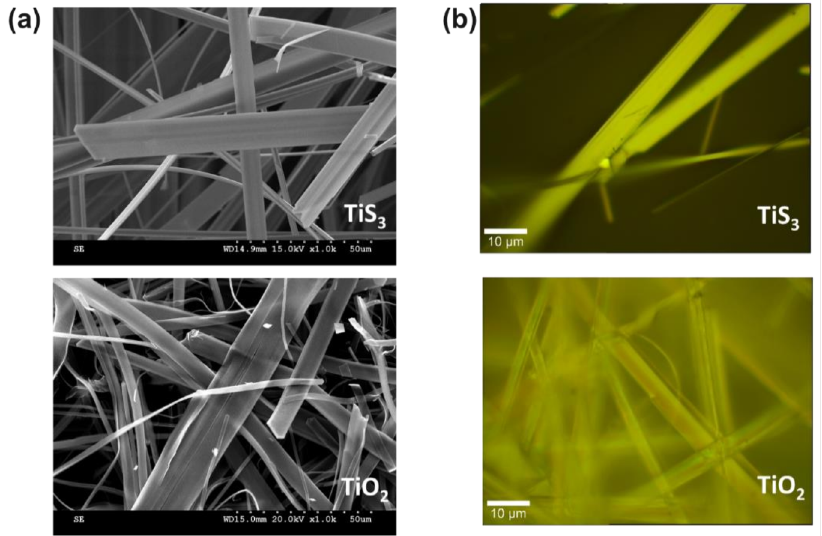
Figure 1. ( a ) Scanning electron micrographs of TiS 3 (top) and TiO 2 (bottom). ( b ) Optical microscopy image of TiS 3 (top) and TiO 2 (bottom).